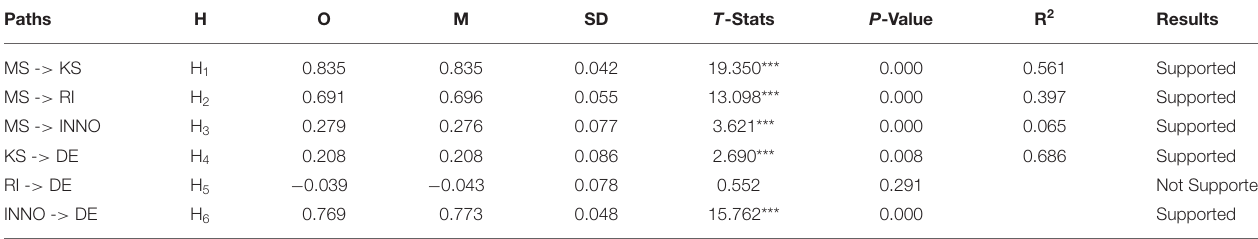
TABLE 5 | Results for structural model.